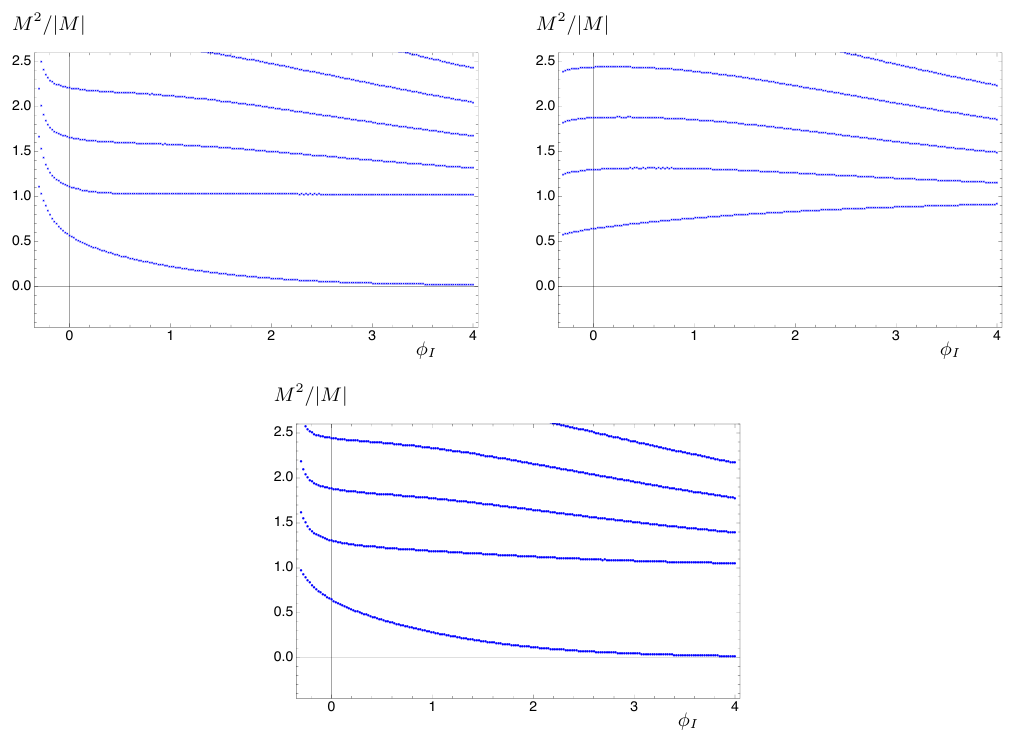
Figure 3 . Mass spectrum, with M 2 = − q 2 , of the three groups of pseudoscalar modes and their excited states as a function of the parameter φ The markers are chosen to match the representations under SO(4) . Left to right and top to bottom: the fourth, fifth and sixth element of H (1) A and ρ = 10 2